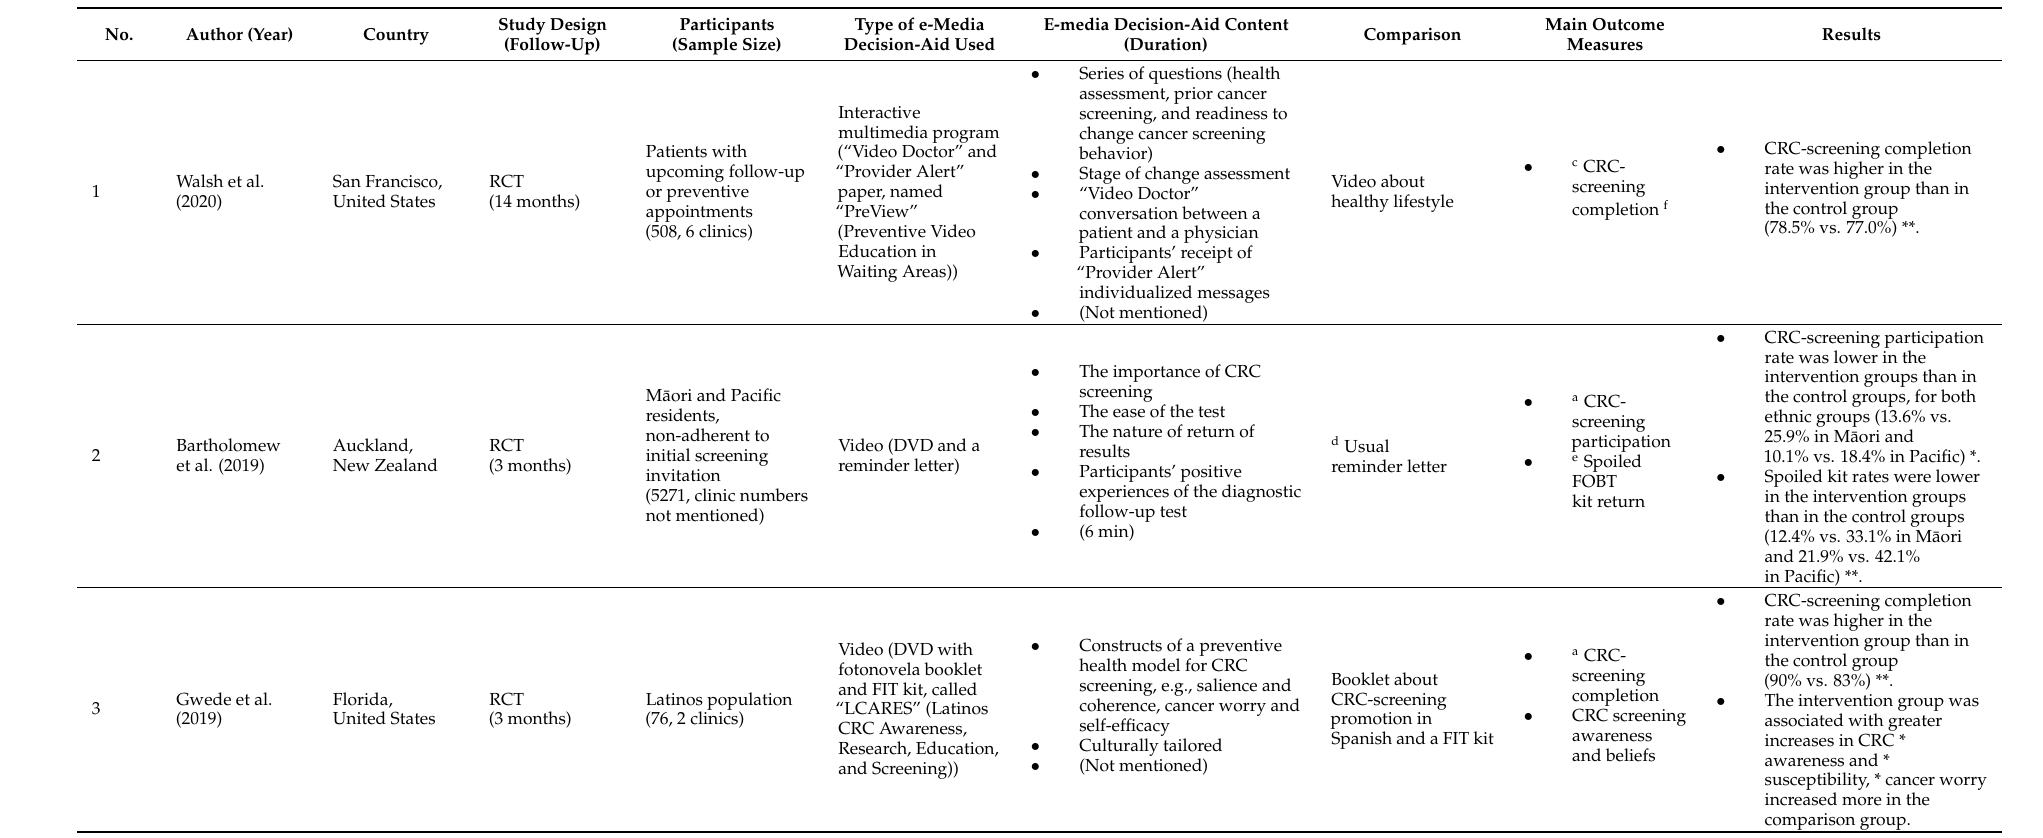
Table 2. Table of evidence from all ten studies in this review ( N =